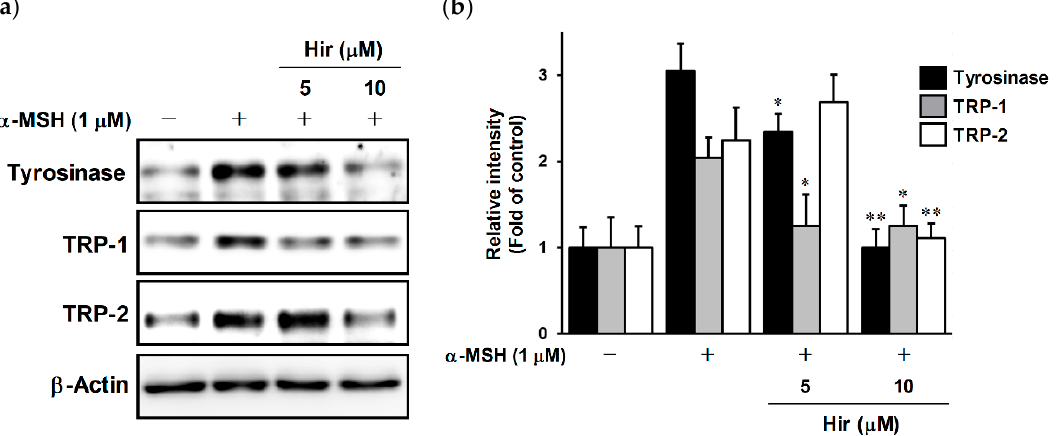
Figure 5. Effect of Hir on the protein levels of tyrosinase, TRP-1, and TRP-2 in B16-F1 cells. ( a ) The cells were treated with Hir at the indicated concentrations for 1 h, then stimulated with α -MSH for 48 h. Protein expression was determined by Western blotting as described in Materials and Methods. ( b ) Band intensities were quantified using ImageJ software and normalized to the band intensities of β -action as an internal control. The data shown are representative of 3–4 independent experiments. * p < 0.05 and ** p < 0.01 versus α -MSH.